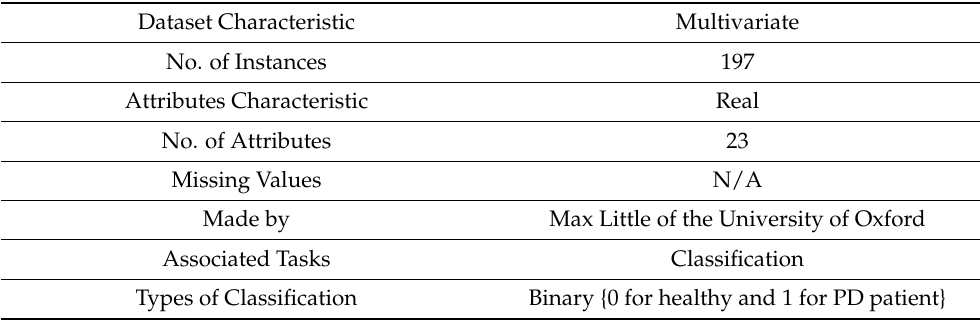
Table 2. Detail of Parkinson’s